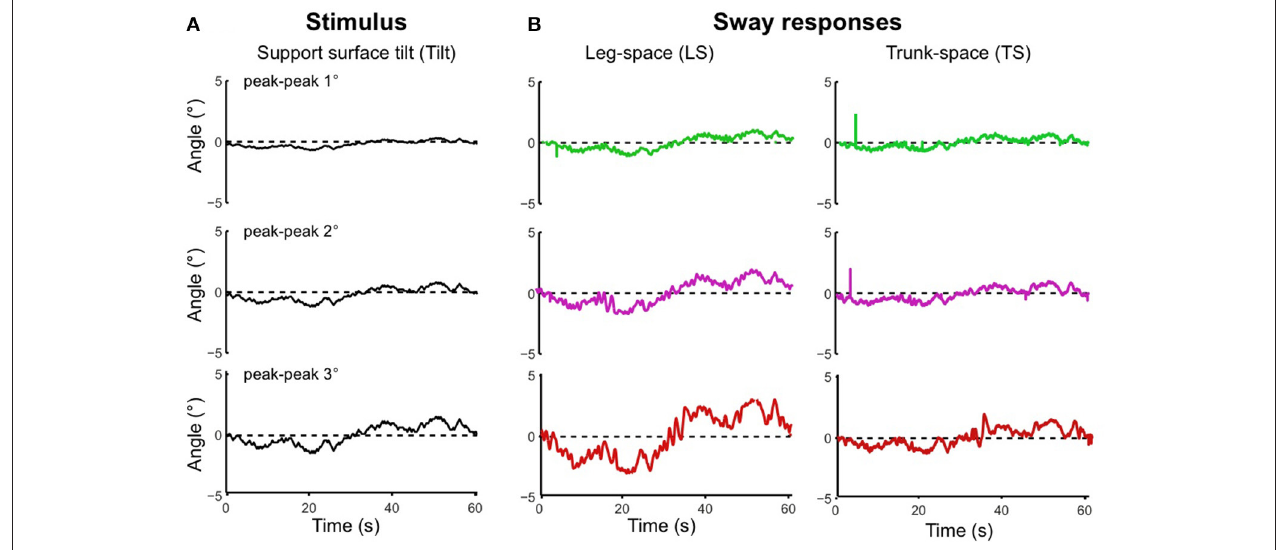
FIGURE 11 | Time series of stimulus and sway responses of the robot without vestibular function to support surface tilt. (A) PRTS tilt stimuli of peak-peak amplitudes of 1 ◦ , 2 ◦ , and 3 ◦ . (B) Responses of leg in space, LS, and trunk in space, TS. Limiting tilt peak-peak amplitudes to 3 ◦ prevented falling.